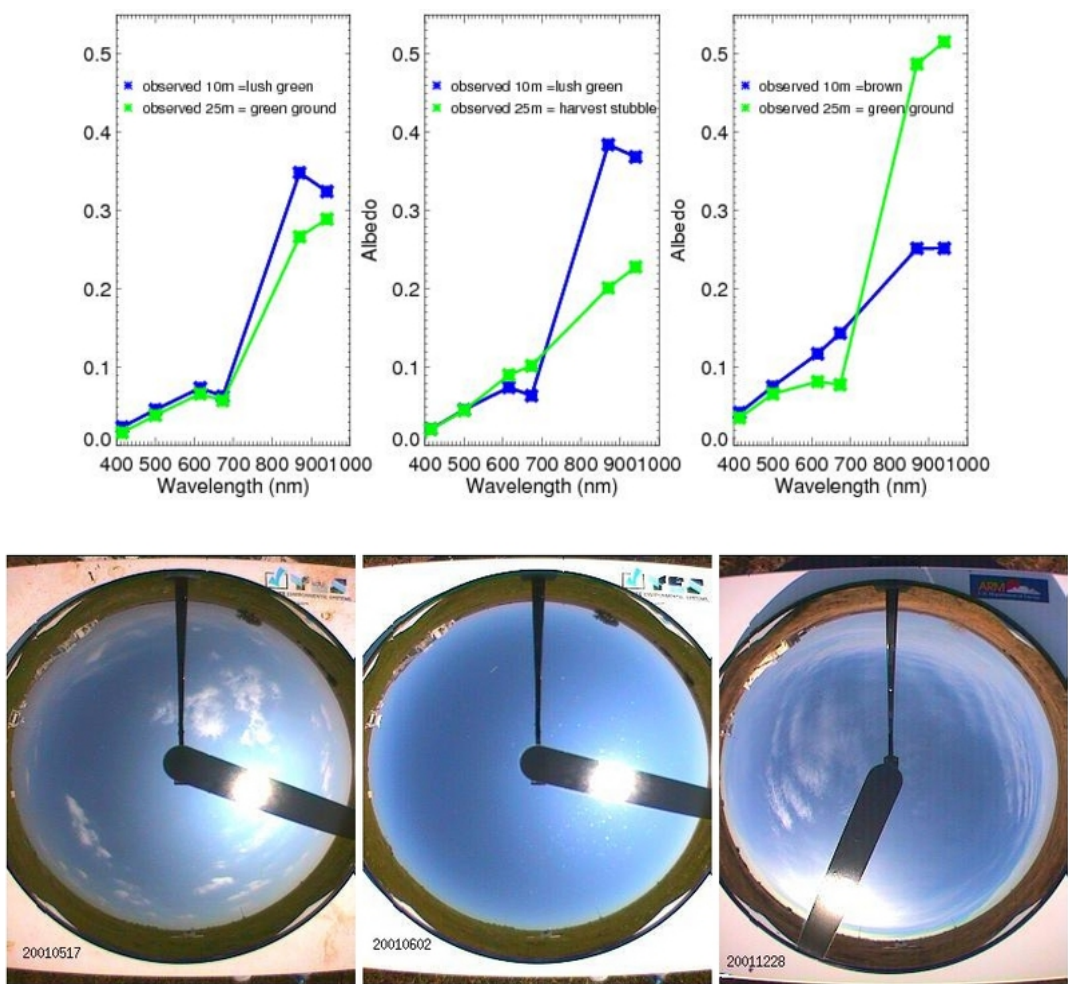
Fig. 3. Examples of (top) MFR measurements and (bottom) TSI images for several different surface types as indicated by observers in the surflog